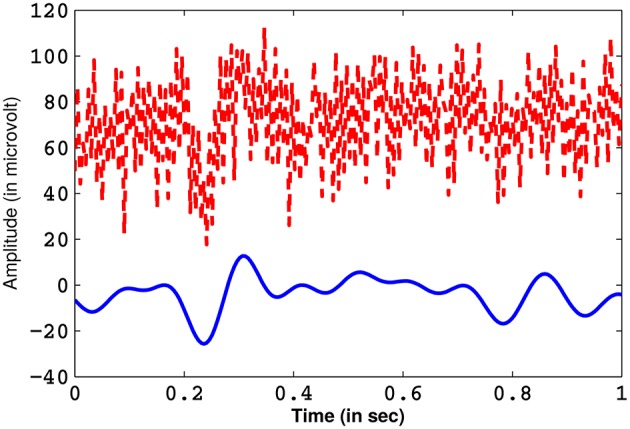
The ErrP signal obtained from channel Cz after filtering (in blue) and its unfiltered counterpart (in red).